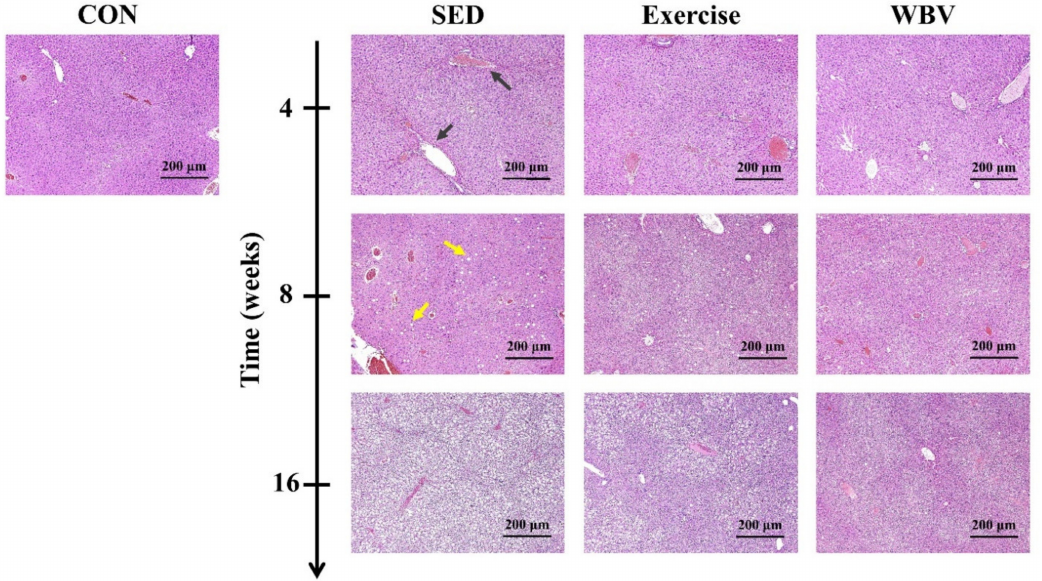
Figure 3. Hematoxylin-and-eosin-stained liver sections obtained from various groups and during different intervention periods. CON: control; SED: sedentary; WBV: whole-body vibration. Black arrows represent vessels; some of them contain red blood cells. Yellow arrows indicate fatty